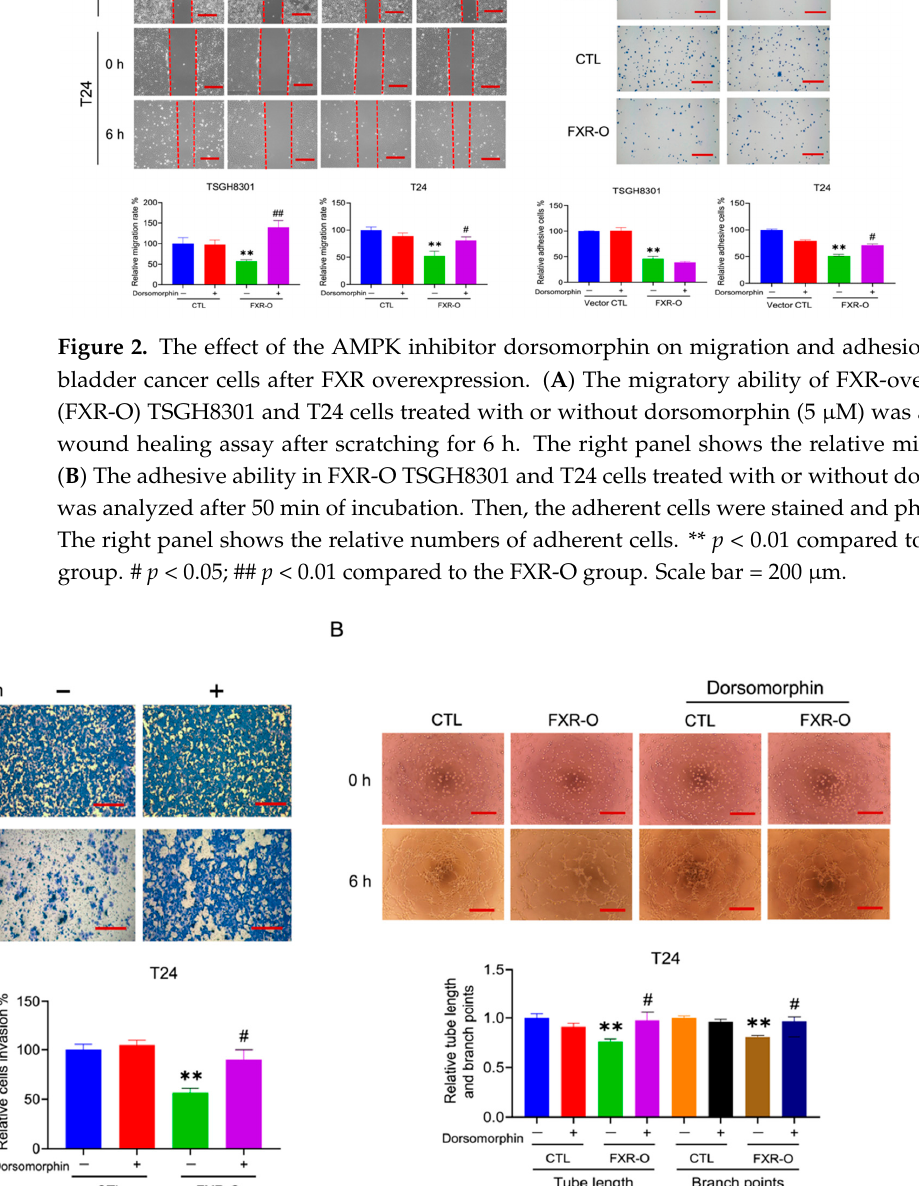
Figure 3. The effect of dorsomorphin on invasion and angiogenesis of human bladder cancer T24 cells after FXR overexpression. ( A ) The invasive ability of muscle-invasive FXR-O T24 cells treated with or without dorsomorphin was analyzed by Transwell assay with Matrigel for 18 h. The cells were stained and imaged. The lower panel shows the quantitative results. ( B ) HUVECs were cultured with control or FXR-O conditioned medium with or without dorsomorphin for 6 h. The number of branch points and lengths of endothelial cell networks were analyzed. The quantitative results of relative branch point numbers and tube lengths were shown as below. ** p < 0.01 compared to the control group; # p < 0.05 compared to the FXR-O group. Scale bar = 200 µ